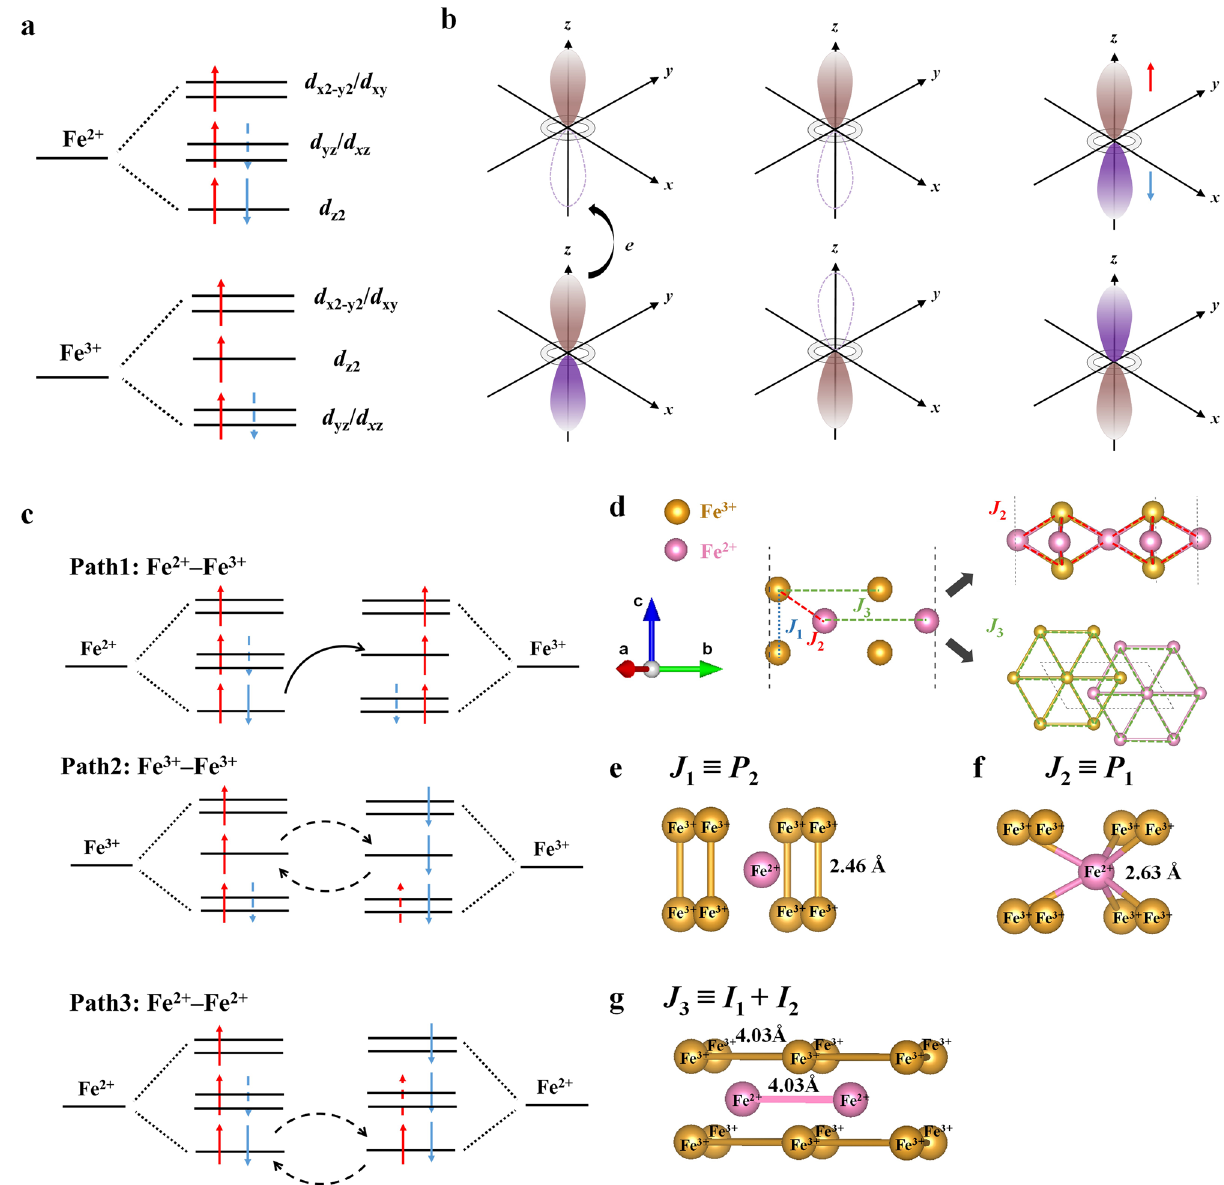
Fig. 2 Magnetic exchange interaction in 2D Fe 3 GeTe 2 . a Schematic representation of the splitting of d orbitals in Fe 2 + and Fe 3 + ions, respectively. b Three possible processes for the exchange between localized d z 2 orbitals. c The corresponding three possible localized Fe – Fe exchange paths in the Fe 3 GeTe 2 crystal. d Side view showing the magnetic exchange parameters J 1 , J 2 , and J 3 for the Fe – Fe coupling in Fe 3 GeTe 2 crystal, together with the Fe – Fe exchange interaction paths for these parameters in monolayer Fe 3 GeTe 2 . e – g Schematic representations of the exchange parameters J 1 , J 2 , and J 3 , respectively. Table 1 Structure and magnetic parameters in 2D Fe n GeTe 2 (4 ≤ n ≤ 7).